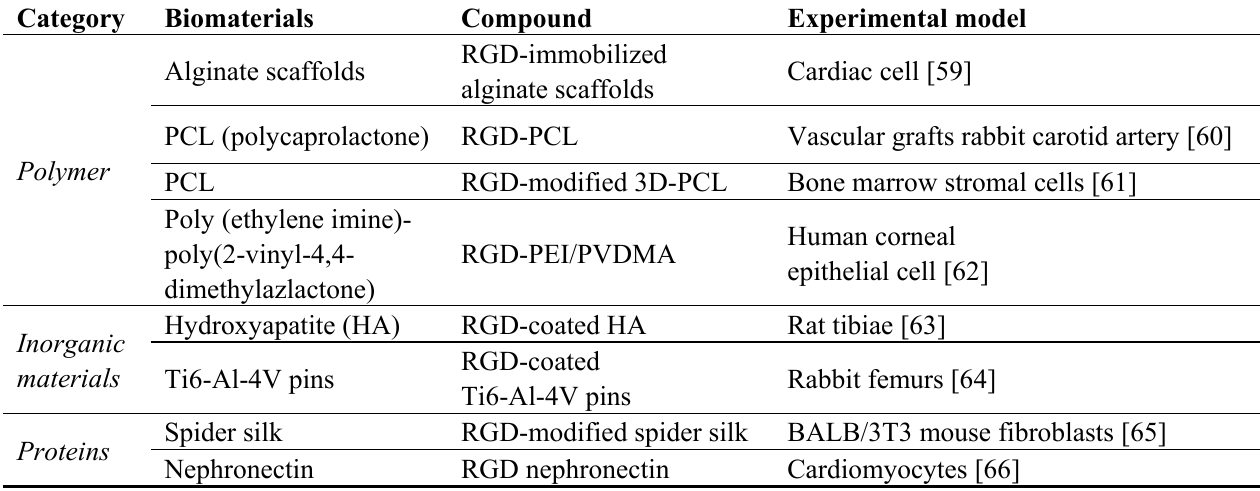
Table 4. RGD-peptide modified